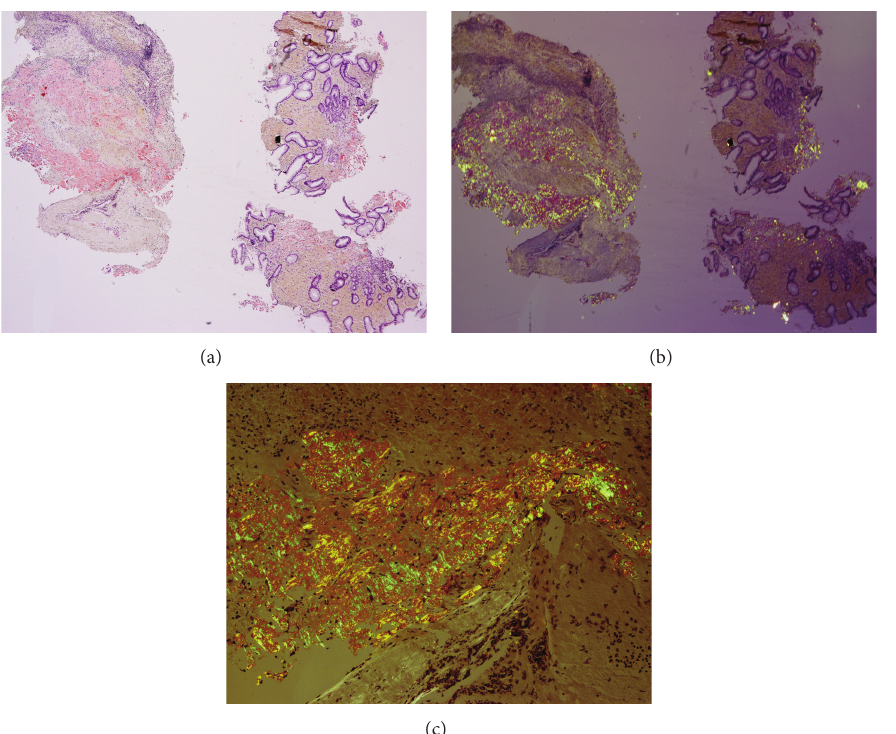
Figure 2: Low-power photomicrograph of endoscopic biopsies of the gastric mass using a Congo red stain revealed rose-pink staining of the amyloid deposits (a). Low-power (b) and high-power (c) photomicrographs of Congo red stain from the same sections using polarized light revealed the classic apple-green birefringence. Note that the regions exhibiting apple-green birefringence in (b) and (c) correspond to the same regions revealing rose-pink staining in (a). Note the presence of typical gastric glands on the right sides of (a) and